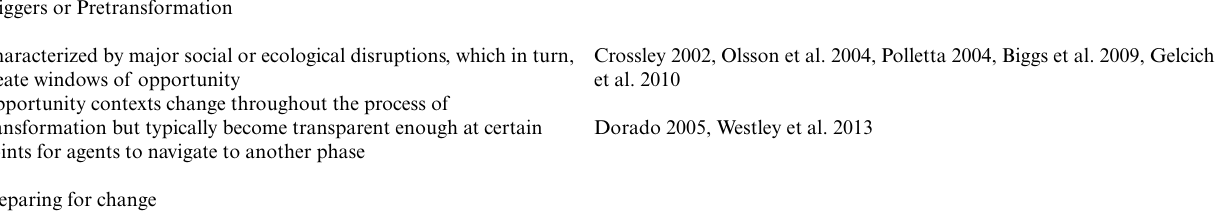
Table 1. Framework for analyzing the multiple subprocesses in each phase of a social-ecological system transformation process. Triggers or